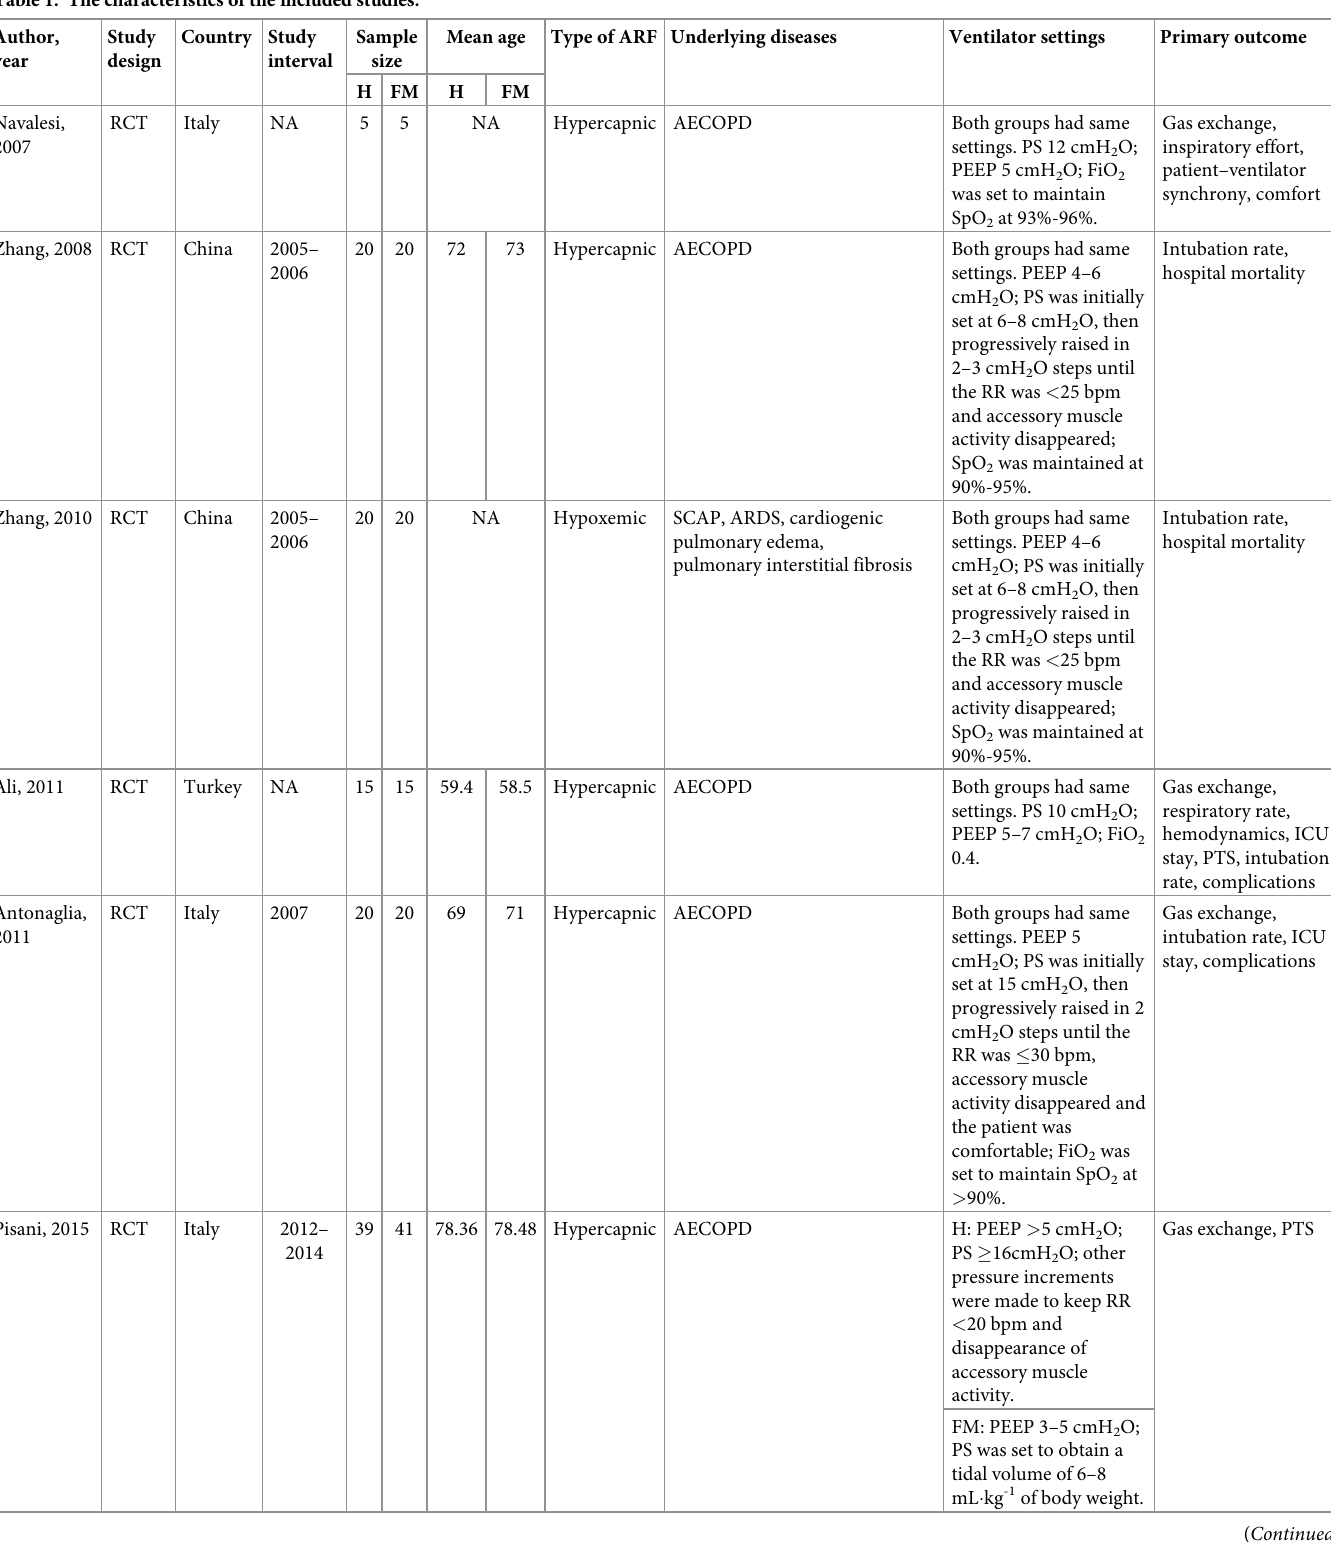
Table 1. The characteristics of the included